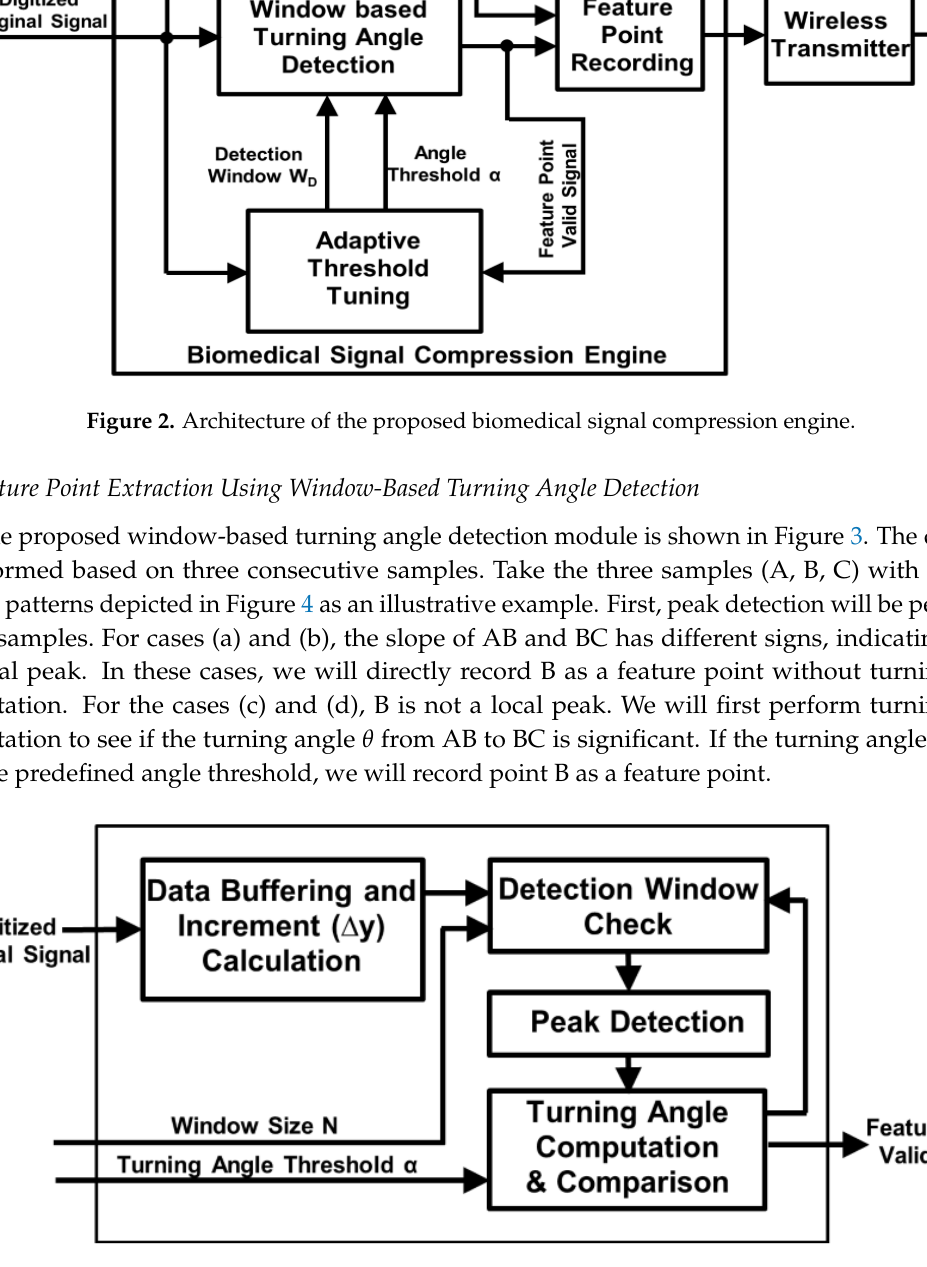
Figure 3. Window-based turning angle detection module.